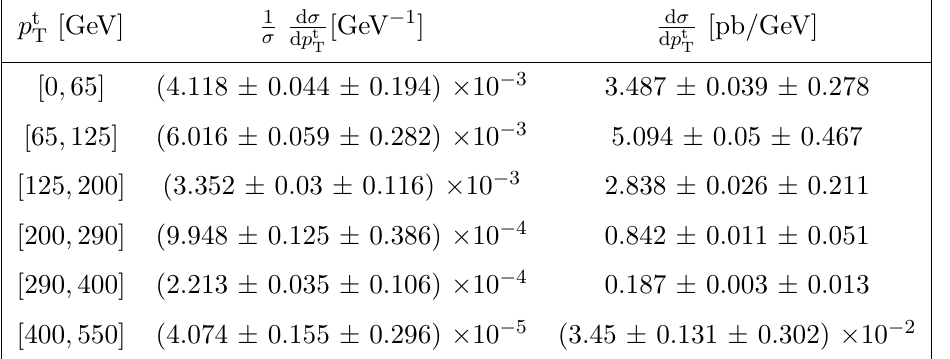
Table 1 . The measured di(cid:11)erential cross section and bin boundaries for each bin of the normalized and absolute measurements of the tt di(cid:11)erential cross section at parton level in the full phase space as a function of p t are tabulated. T